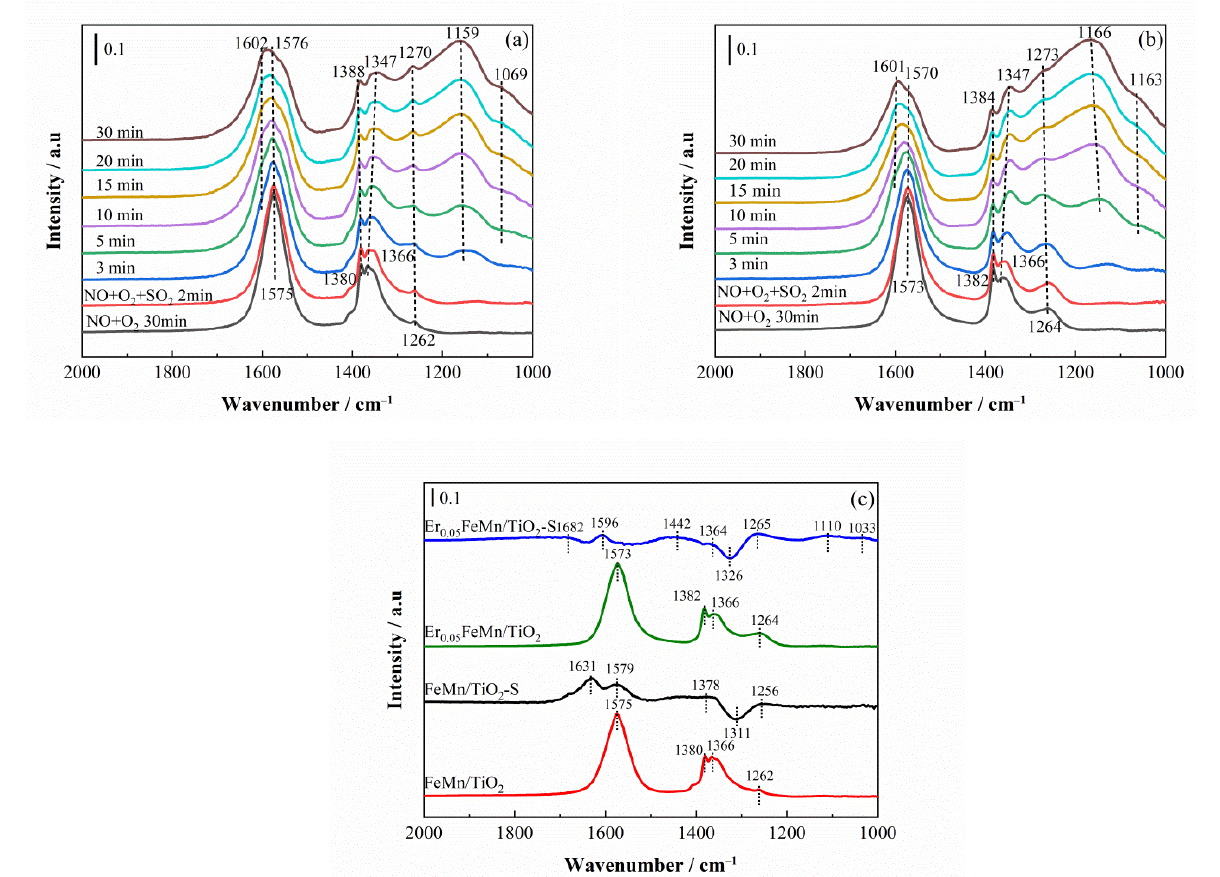
Figure 9. In-situ DRIFTS spectra FeMn/TiO 2 ( a ) and Er 0.05 FeMn/TiO 2 ( b ) catalysts exposed to 500 ppm NO + 5% O 2 fol- lowed by the introduction of 100 ppm SO 2 at 200 °C, and in-situ DRIFTS spectra of adsorption 500 ppm NO + 5% O 2 over the fresh and used catalysts at 200 °C ( c ).